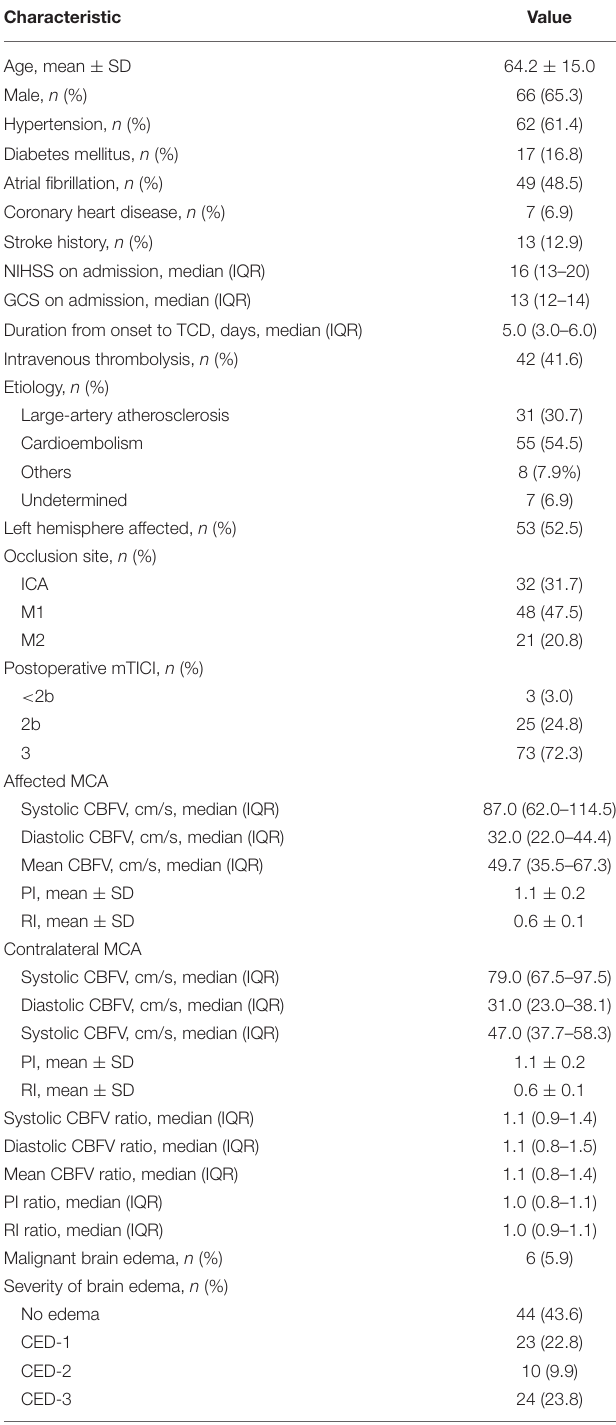
TABLE 1 | Baseline characteristics and outcomes of included